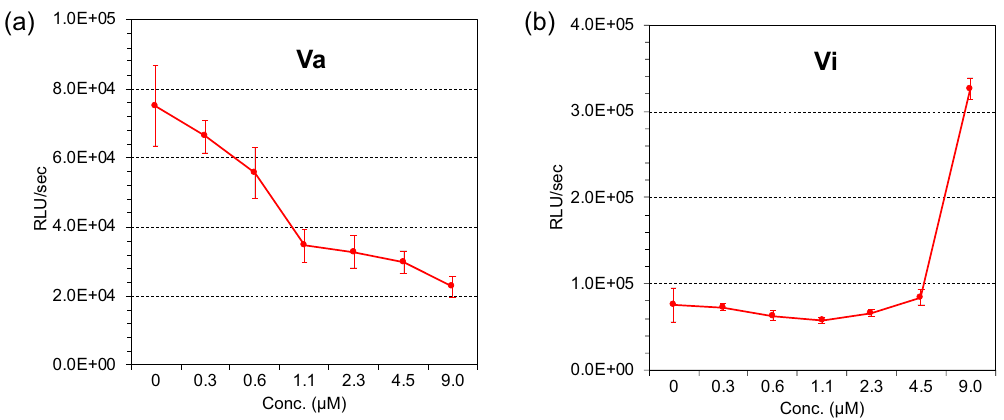
Figure 2. Compound concentration-dependent effects on the proliferation of the rabies virus: ( a ) Antiviral activity of Va and ( b ) activation of rabies virus proliferation by Vi. Compound concentration is reported on the x axis and fluorescent intensity on the y axis.